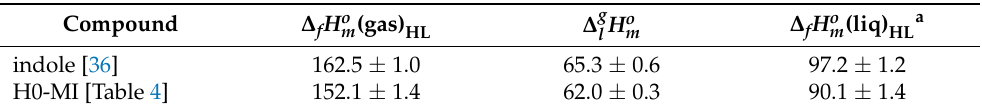
Table 8. Liquid phase enthalpies of formation, ∆ f H o m (liq), of the hydrogen-lean counter-parts, at